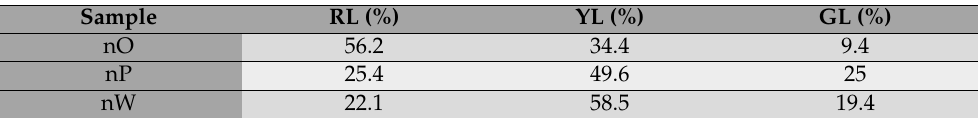
Table 1. A compression table for the deconvoluted luminescence of the broad defect present in the heterostructure.